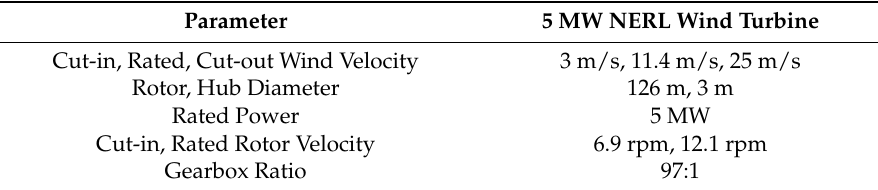
Table A1. 5-MW wind turbine specifications.